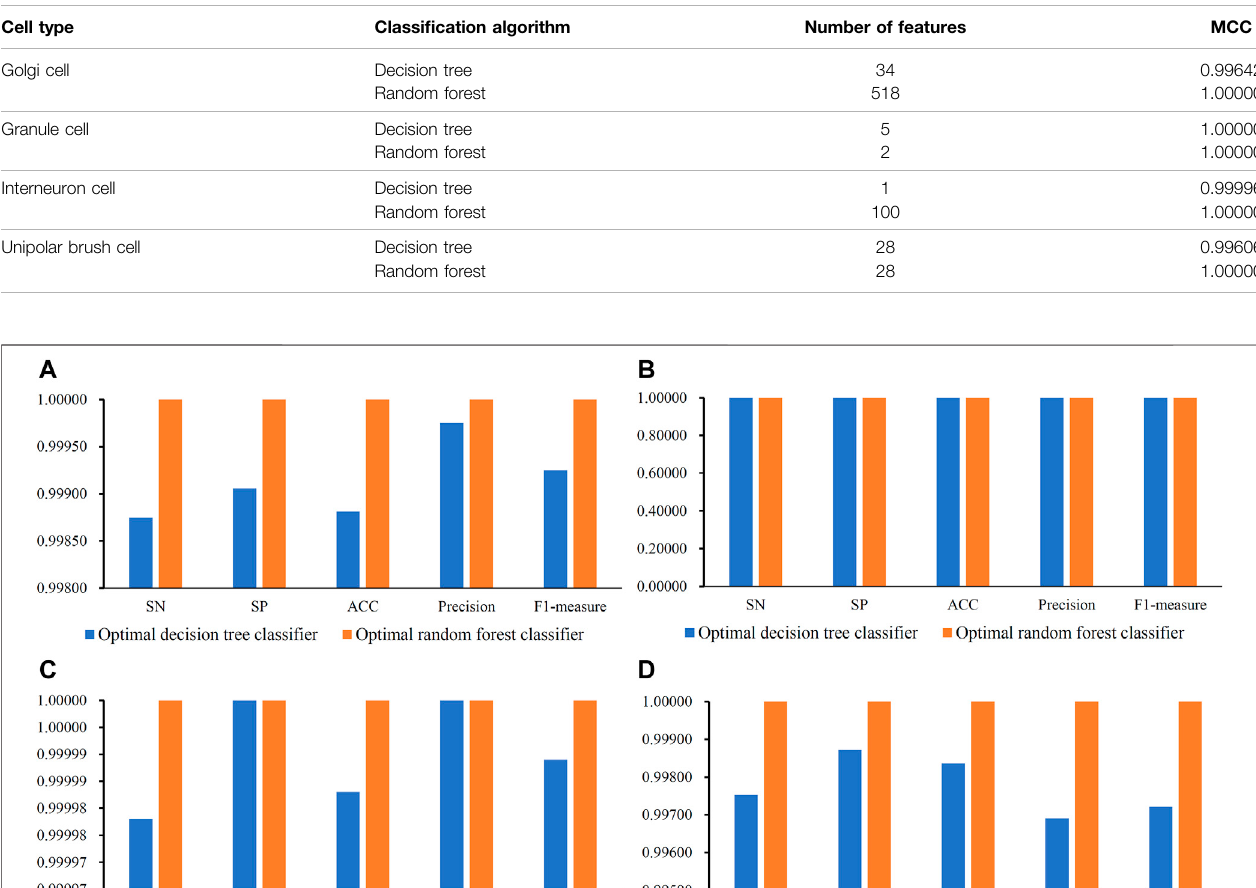
TABLE 2 | Performance of optimal classi fi ers on four datasets using different classi fi cation algorithms.